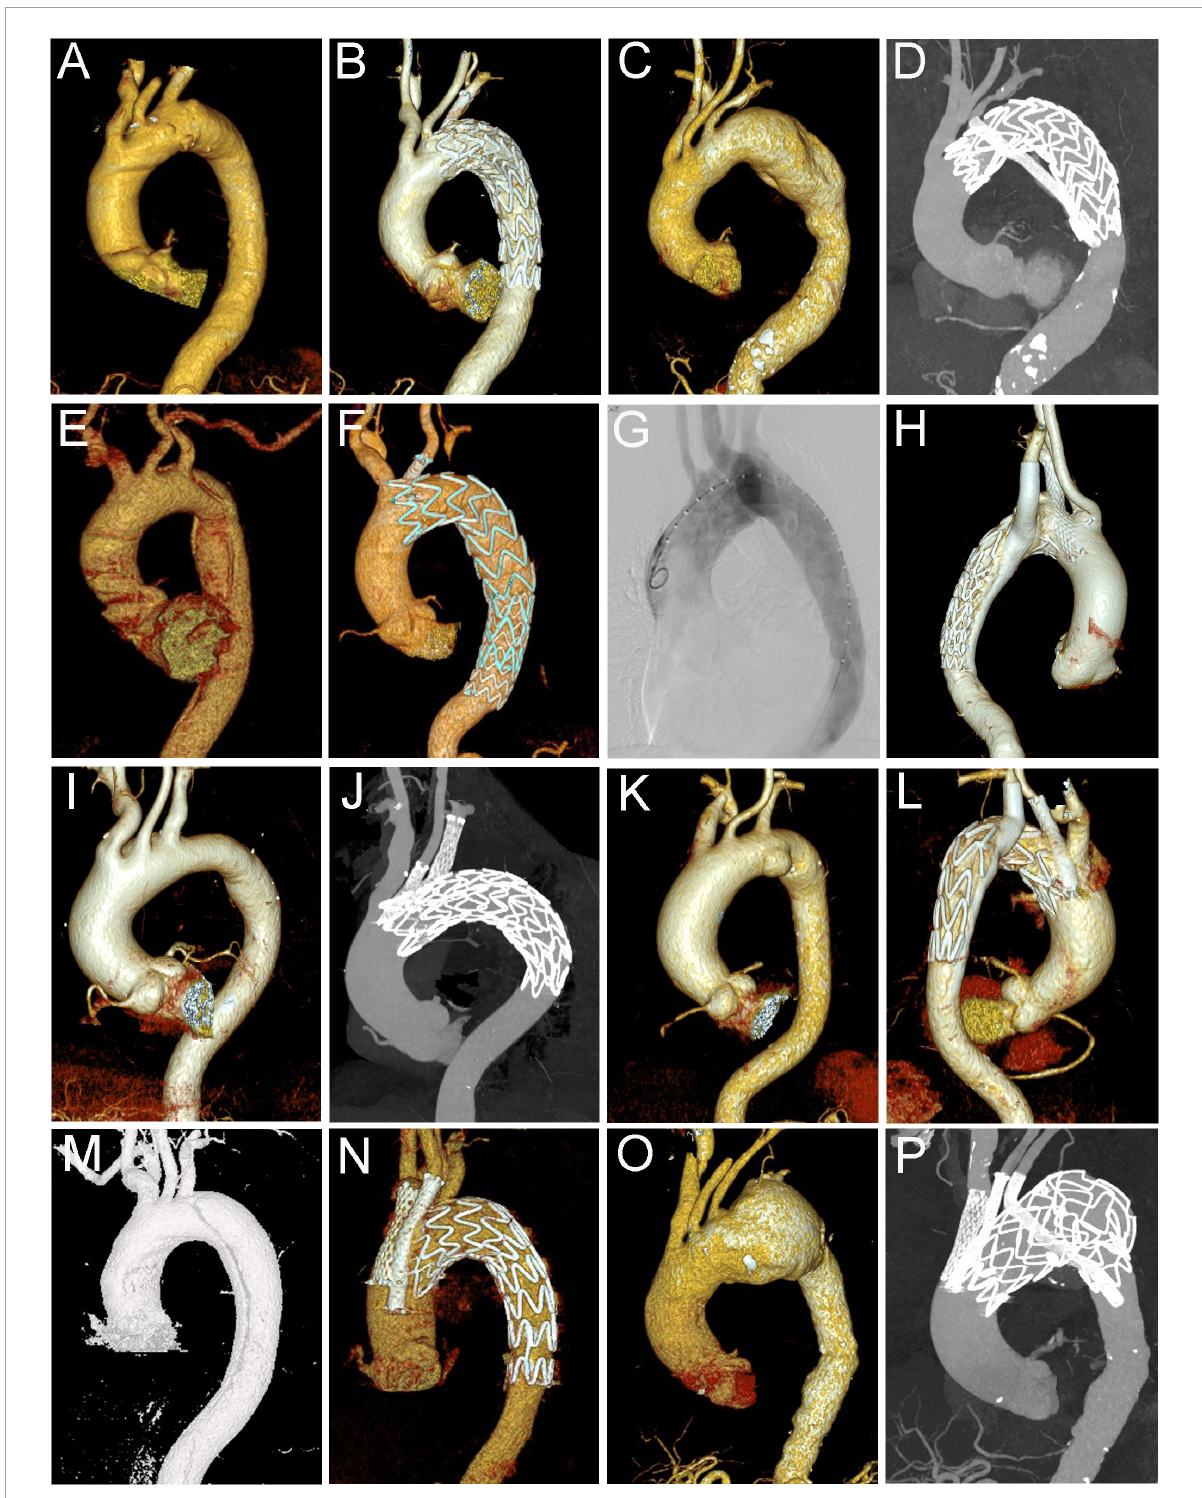
FIGURE1 Different types of cTEVAR in the study. (A,B) Chimney stent in LSA; (C,D) snorkel stent in LSA; (E,F) chimney stent in LCCA; (G,H) chimney stent in LSA and snorkel stent in aRSA; (I,J) chimney stents in LCCA and LSA; (K,L) chimney stent in LCCA and snorkel stent in LSA; (M,N) chimney stents in IA and LCCA; (O,P) chimney stents in IA and LCCA, and snorkel stent in LSA. cTEVAR, TEVAR with chimney; IA, innominate artery; LCCA, left common carotid artery; LSA, left subclavian artery; aRSA, aberrant right subclavian